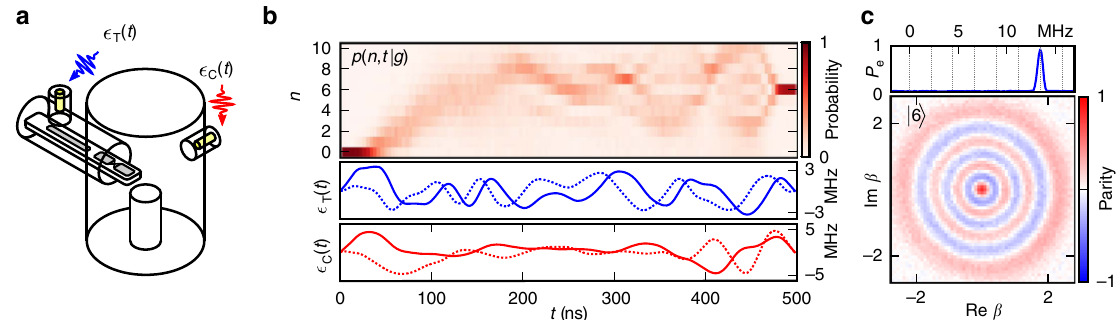
Fig. 1 Experimental system and demonstration of control strategy. a Schematic drawing of the experimental system. A λ /4 coax-stub cavity resonator is coupled to a transmon and readout resonator on a sapphire substrate. Input couplers close to the transmon and cavity deliver the respective time- dependent microwave control fi elds ϵ T ( t ) and ϵ C ( t ). b Lower panel : optimized transmon and oscillator control waveforms of length approximately 2 π / χ to take the oscillator from vacuum to the 6-photon Fock state. Solid ( dotted ) lines represent the in-phase (quadrature) fi eld component. Upper panel : oscillator photon-number population trajectory vs. time conditioned on transmon in g j i . A complex trajectory occupying a wide range of photon numbers is taken to perform the intended operation. c Characterization of the oscillator state using Wigner tomography ( bottom ) and transmon spectroscopy ( top ), where grey dashed lines indicate the transition frequency associated with the fi rst seven Fock states. The single peak in the spectroscopy data directly reveals the oscillator ’ s population due to the dispersive interaction giving a frequency shift of 6 χ /2 π ≈ 13